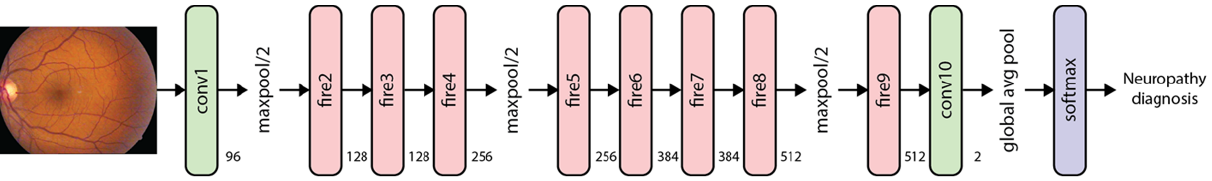
Figure 1. Squeezenet architecture.